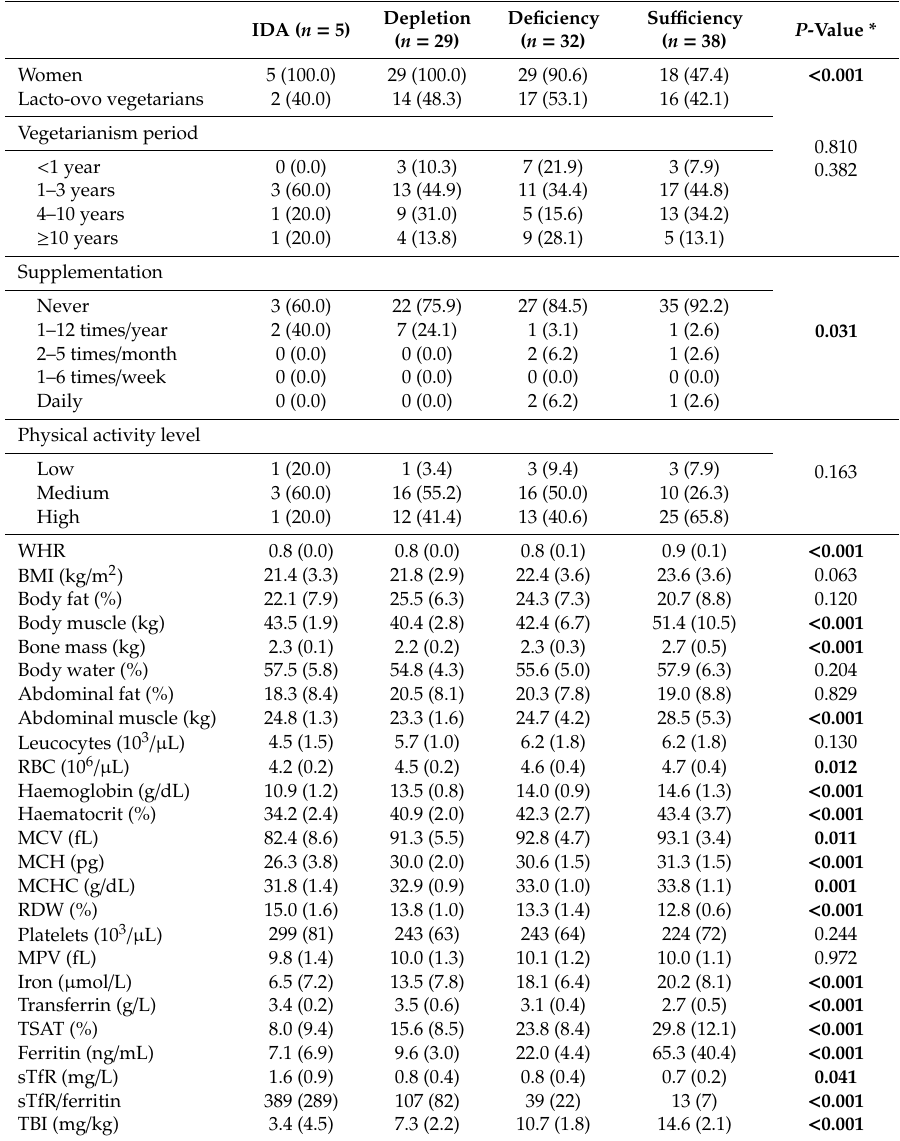
Table 3. The vegetarian pattern, iron supplementation, physical activity, body composition, and iron biomarkers of the volunteers according to iron